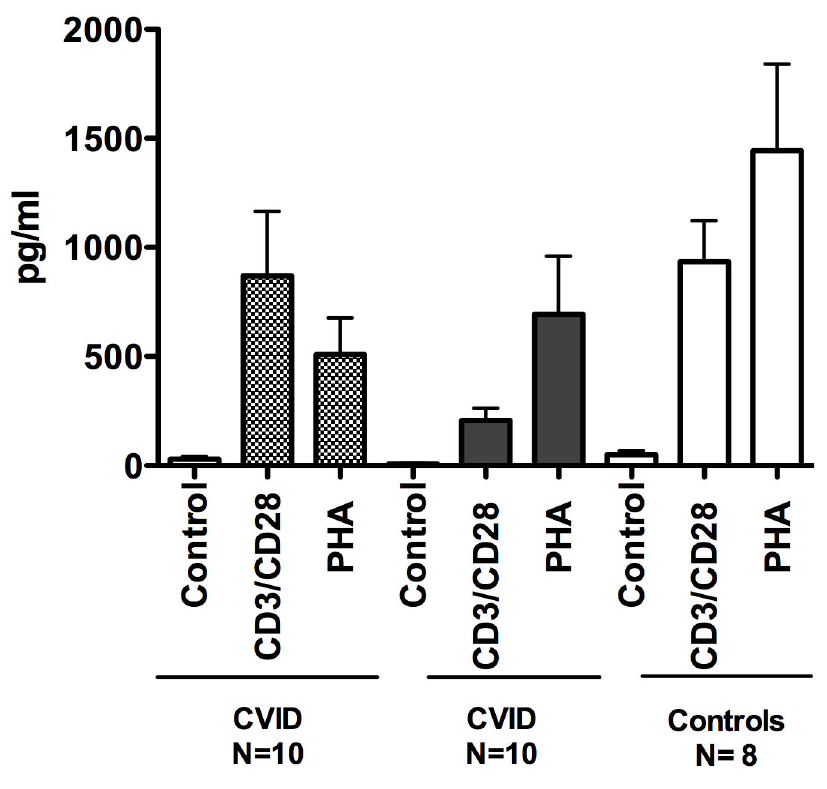
Figure 10. Production of IFN-γ. Culture supernatants of PBMCs of CVID subjects with (10) (CVID+) or without inflammatory (10) (CVID-) complications, activated with media alone, added CD3/CD28 beads or PHA, were assessed by ELISA for IFNγ production after 72 hours, and compared to supernatants of similarly treated cells from normal controls.